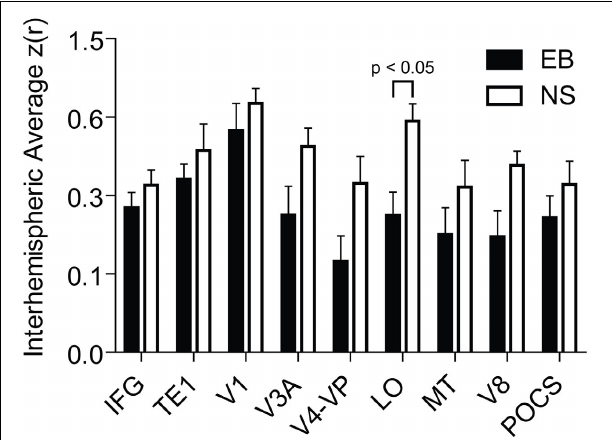
FIGURE 3 | Interhemispheric temporal correlations in homotopic seed regions in early blind (EB) and normally sighted (NS). Plotted data values are mean and standard error of interhemispheric Z ( r ) values. Abbrevations: IFG, inferior frontal gyrus; TE1, core region of primary auditory; V1, primary visual; V3A, visual area 3A; V4-VP, visual areas V4 and VP; LO, lateral occipital cortex; MT, middle-temporal area; V8, visual area 8; POCS, parietal occipital sulcal cortex.